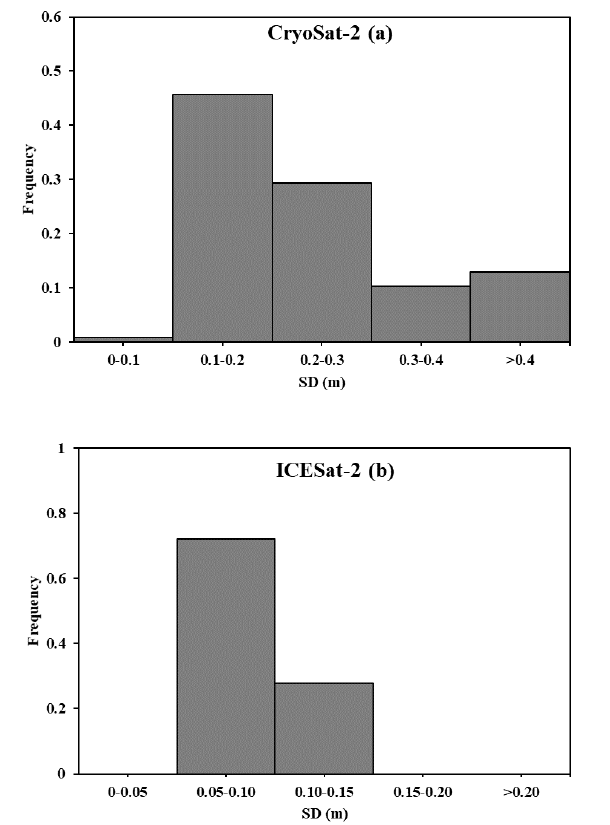
Figure 3 . SD frequency distribution of CryoSat-2 (a) and ICESat-2 (b).